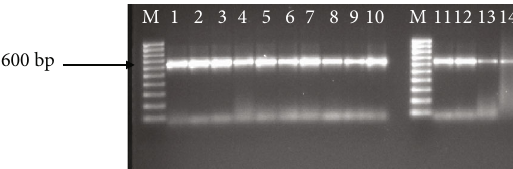
Figure 1: Ampli fi cation of 14 female reniform nematodes using 18S rRNA primers showing a 600bp band. M: 100 bp molecular